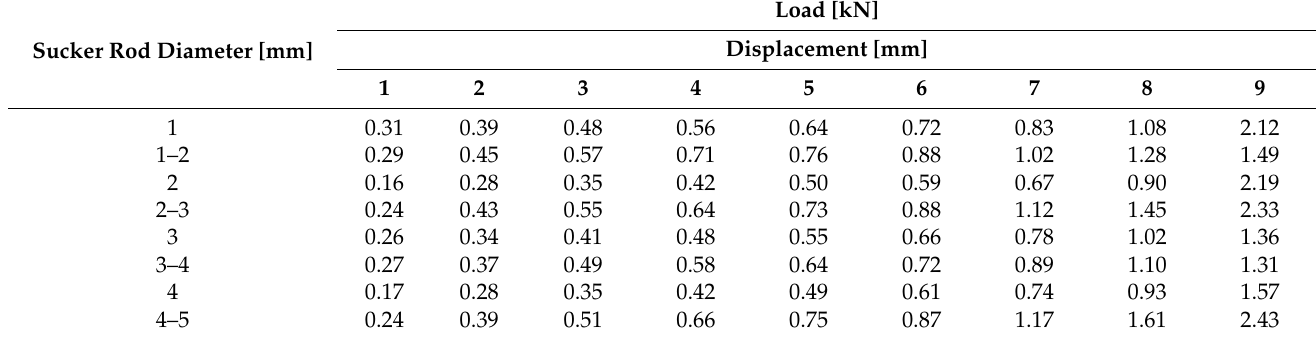
Table 6. Loads on the slats as a function of outer pipe displacement when a centering degree of 67% was